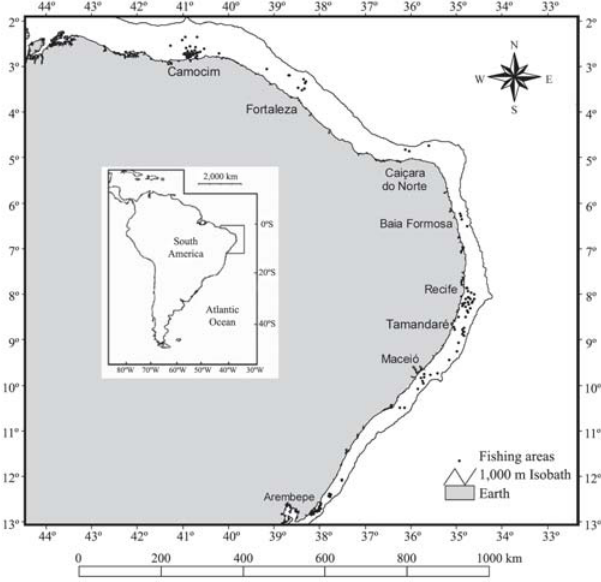
Fig. 1. Sampling locations and fishing areas of Spanish mackerel ( Scomberomorus brasiliensis ) collected off northeastern Brazil.